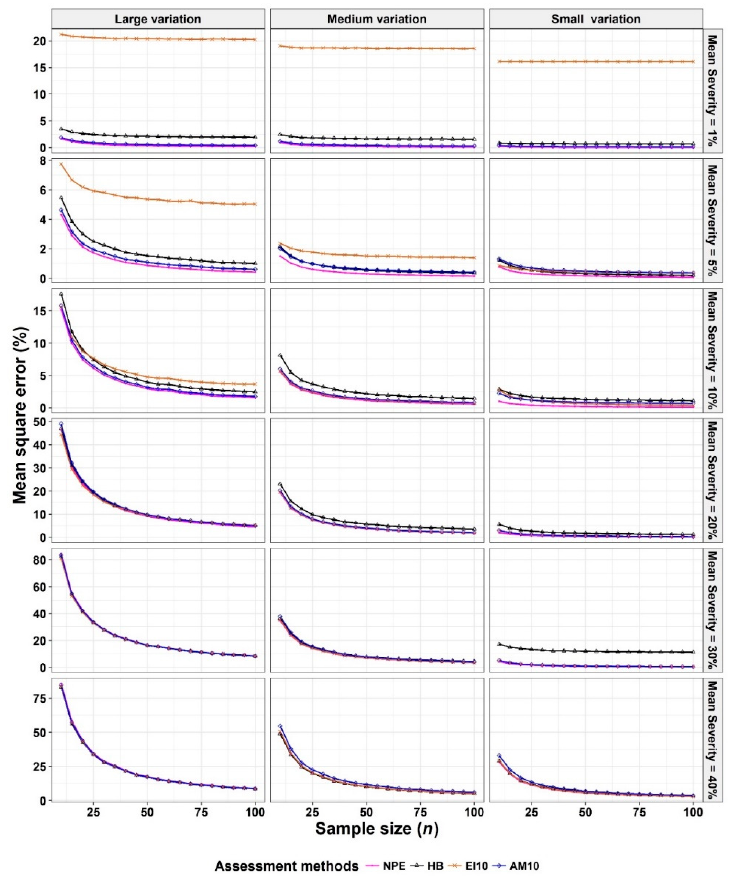
Figure 2. The relationships between the mean squared error (MSE) of mean disease severity estimates and sample size ( n ) (from n = 10 to 100 in n = 5 increments) for each of the different scales used, over a range of “actual” mean disease severities (1, 5, 10, 20, 30, and 40%) and variance (represented by large, medium, and small variation). The simulation process was repeated 10,000 times. Assessment methods: (i) NPE (nearest percentage estimate); (ii) HB (Horsfall-Barratt scale); (iii) AM10 (10% linear scale emphasizing severities ≤ 50% disease, and with additional intervals at severities <10%); (iv) EI10 (10% linear scale).